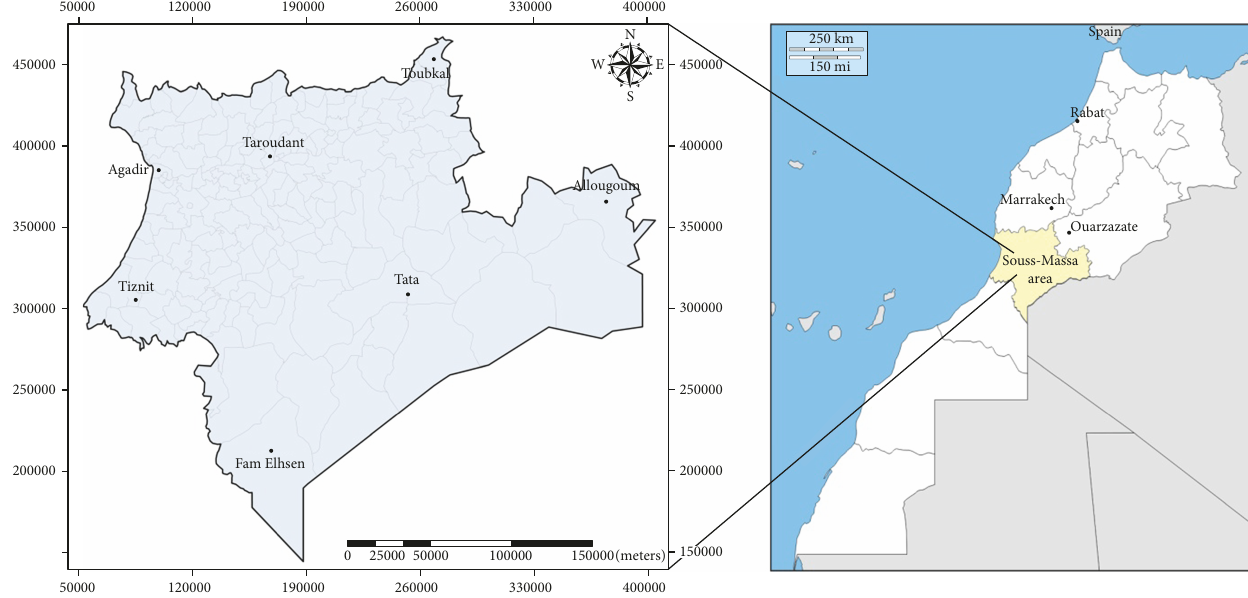
Figure 1: The Souss-Massa area study